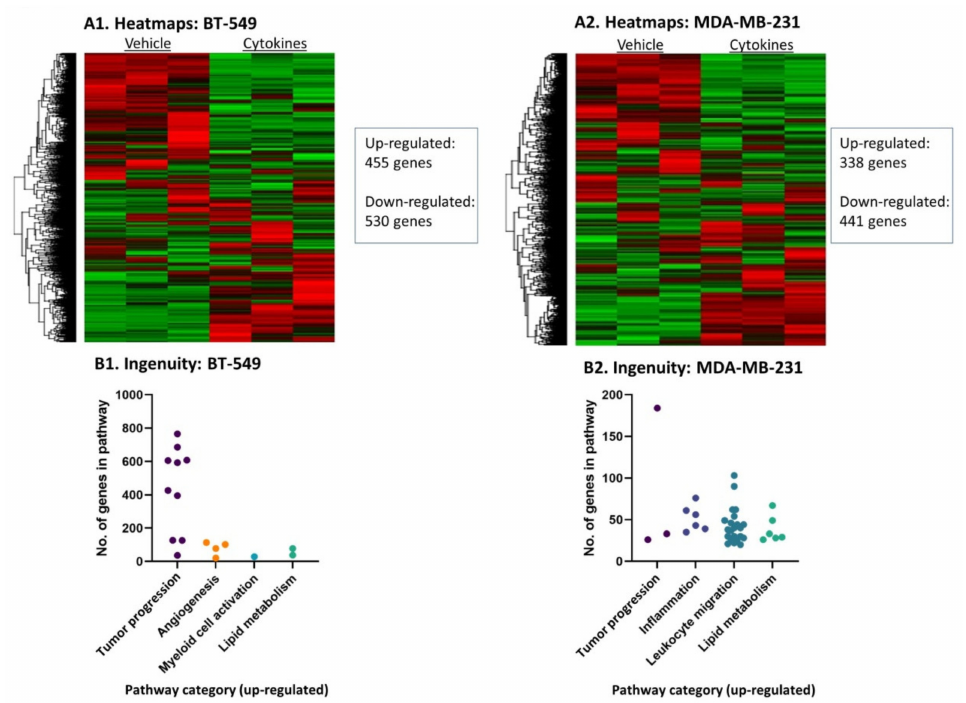
Figure 2. Continuous TNF α + IL-1 β stimulation leads to changes in transcriptional programs in TNBC cells. BT-549 and MDA-MB-231 cells that were continuously stimulated by TNF α + IL- 1 β , or treated by a vehicle control (as described in Figure 1) were subjected to RNAseq analysis. ( A ) Heatmaps of all genes in ( A1 ) BT-549 and ( A2 ) MDA-MB-231 cells. ( B ) Differentially expressed genes that passed the cutoff FC ≥ 2 or FC ≤ − 2 with pFDR < 0.05 were analyzed in Ingenuity program for pathway enrichment analyses. Significantly upregulated (Z-score > 2) annotations that were classified in cancer-related categories are presented in ( B1 ) BT-549 cells and ( B2 ) MDA-MB-231 cells. Each dot represents a category, whose detailed annotations and the number of genes in each annotation are demonstrated in Table S2 (BT-549 cells) and Table S3 (MDA-MB-231